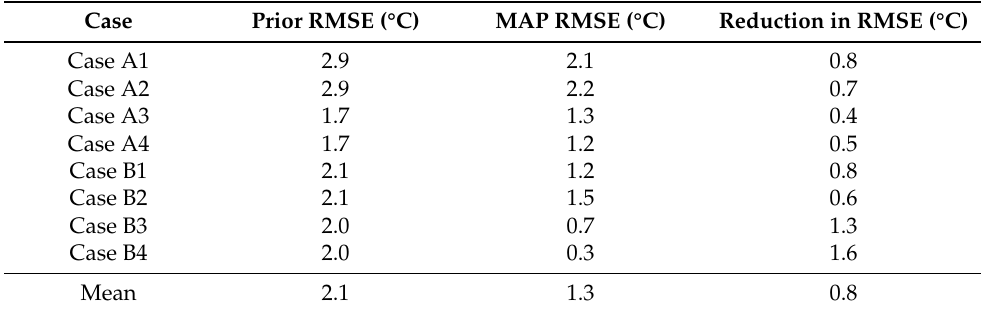
Table 3. Comparison of RMSEs of prior information and MAP solution. Fractions may not match due to